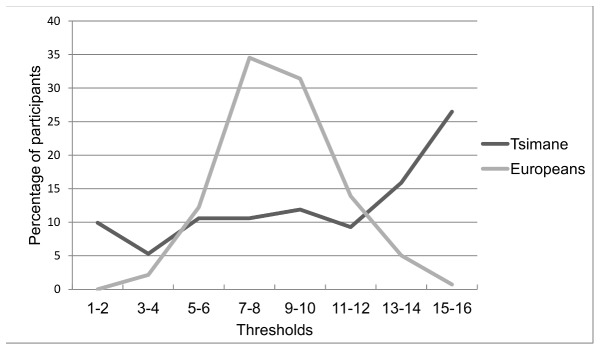
Distributions of scores in odor threshold test for Tsimane’ and European participants.The scores in the test can range between 1 and 16 and they represent geometric series of concentrations of n-butanol (ranging from a 0.04 to 2.7877 × 10–9 n-butanol solution, dilution ratio 1:2).